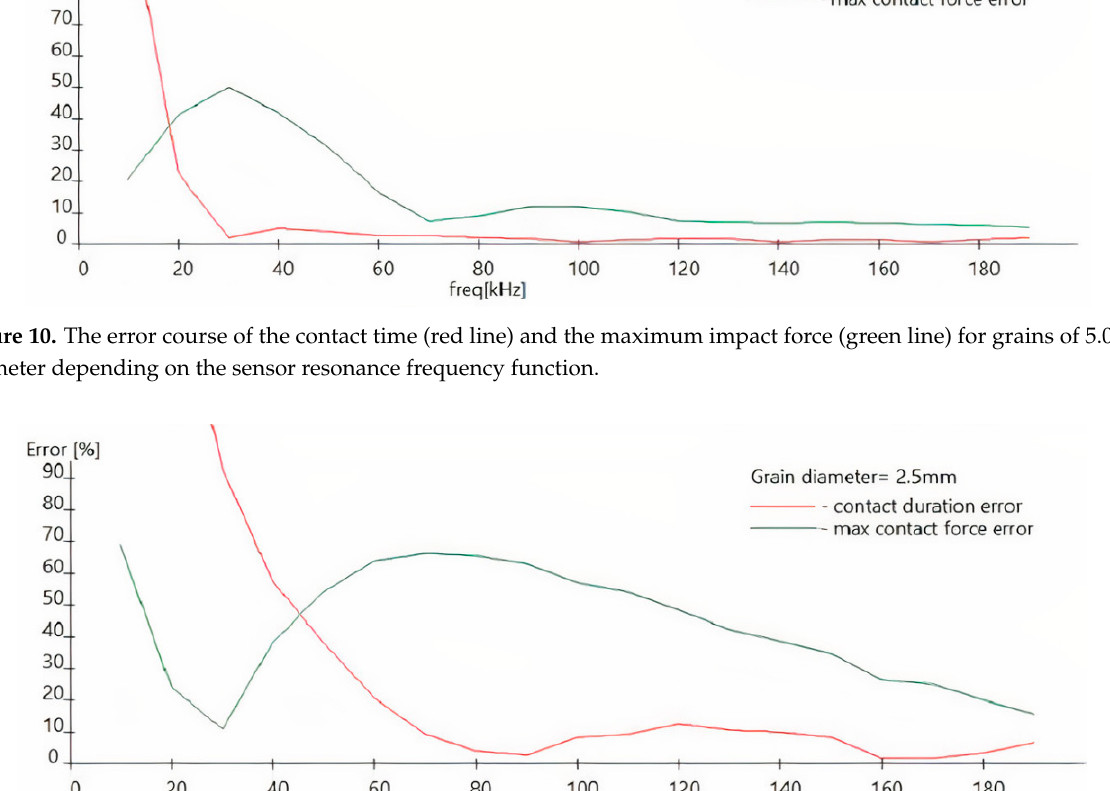
Figure 12. The error course of the contact time (red line) and the maximum impact force (green line) depending on grain diameter.